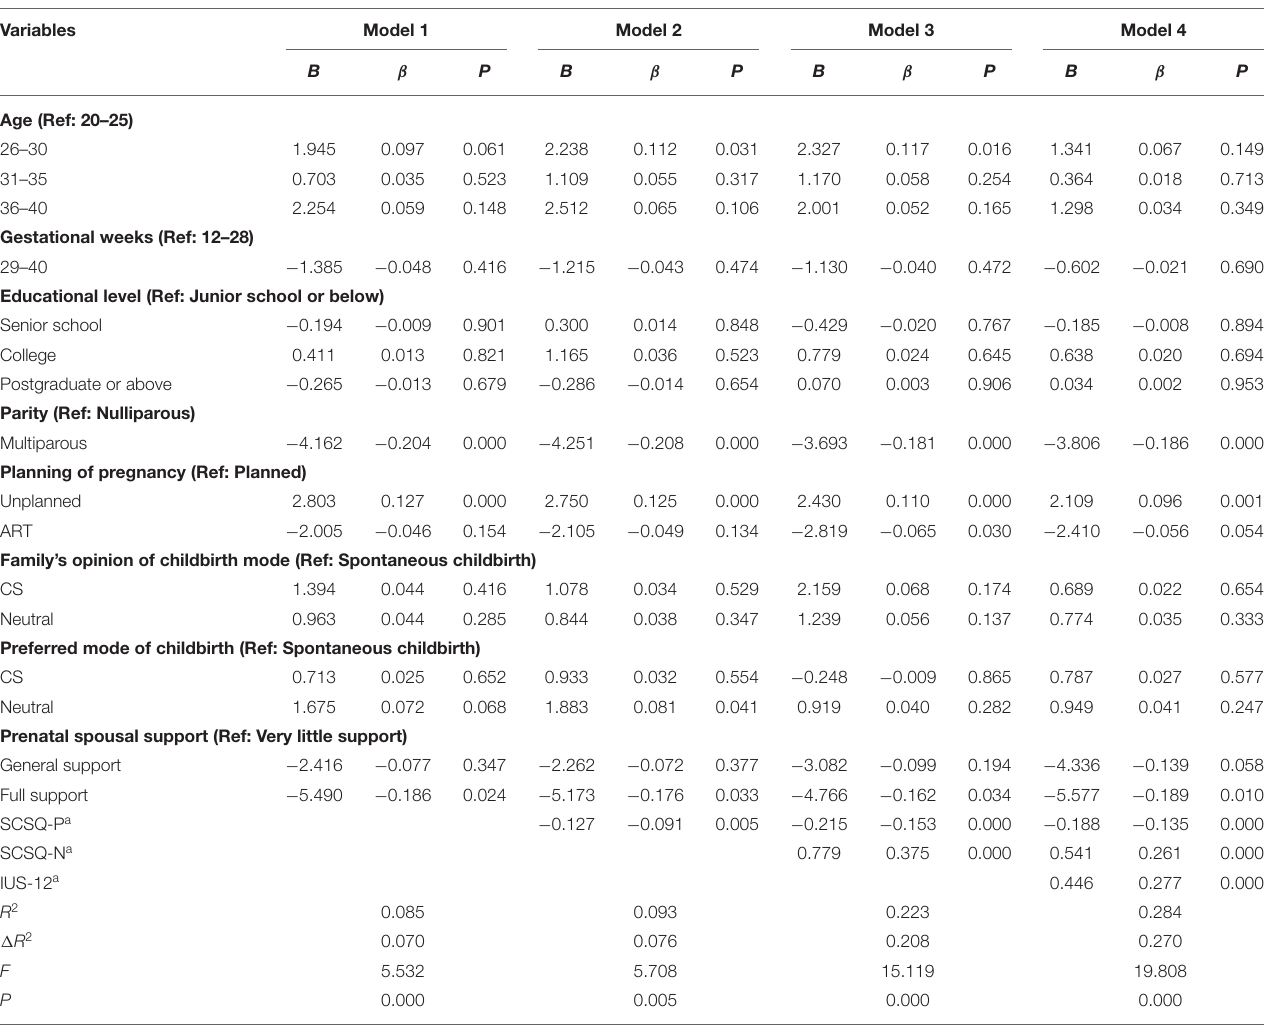
TABLE 4 | Results of hierarchical linear regression analysis for predicting FOC ( N = 969). Variables Model 1 Model 2 Model 3